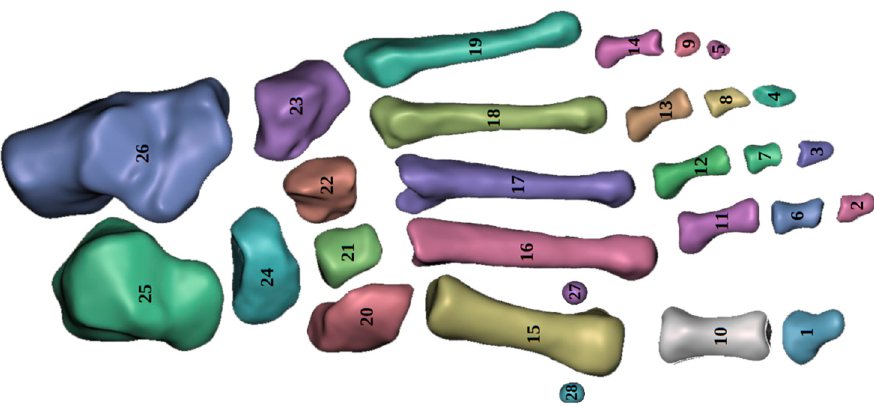
Figure 3. The structure of human foot 3D model. 1—Phalanx distalis hallucis, 2—Phalanx distalis